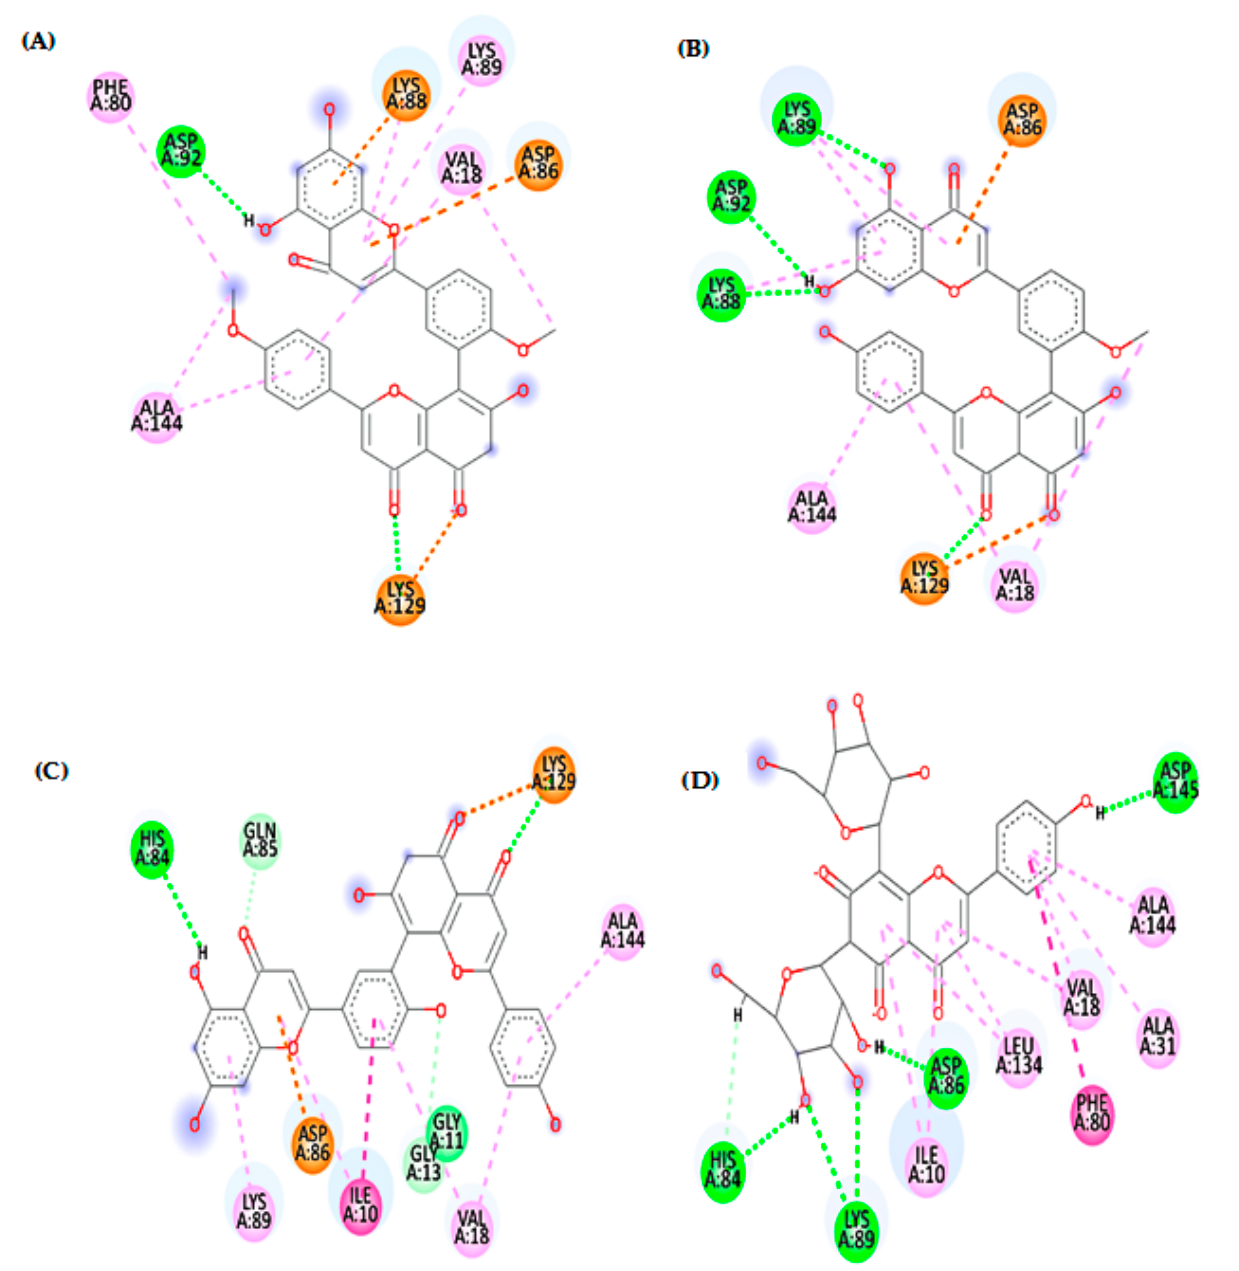
Figure 5. 2D patterns demonstrating the binding interaction of compounds 1 ( A ), 2 ( B ), 4 ( C ) and 6 ( D ) into the active site of CDK-2 (PDB ID: 1FVT); dotted pink, violet and orange lines indicate the hydrophobic interaction, and dotted green lines indicate the hydrogen bonds.